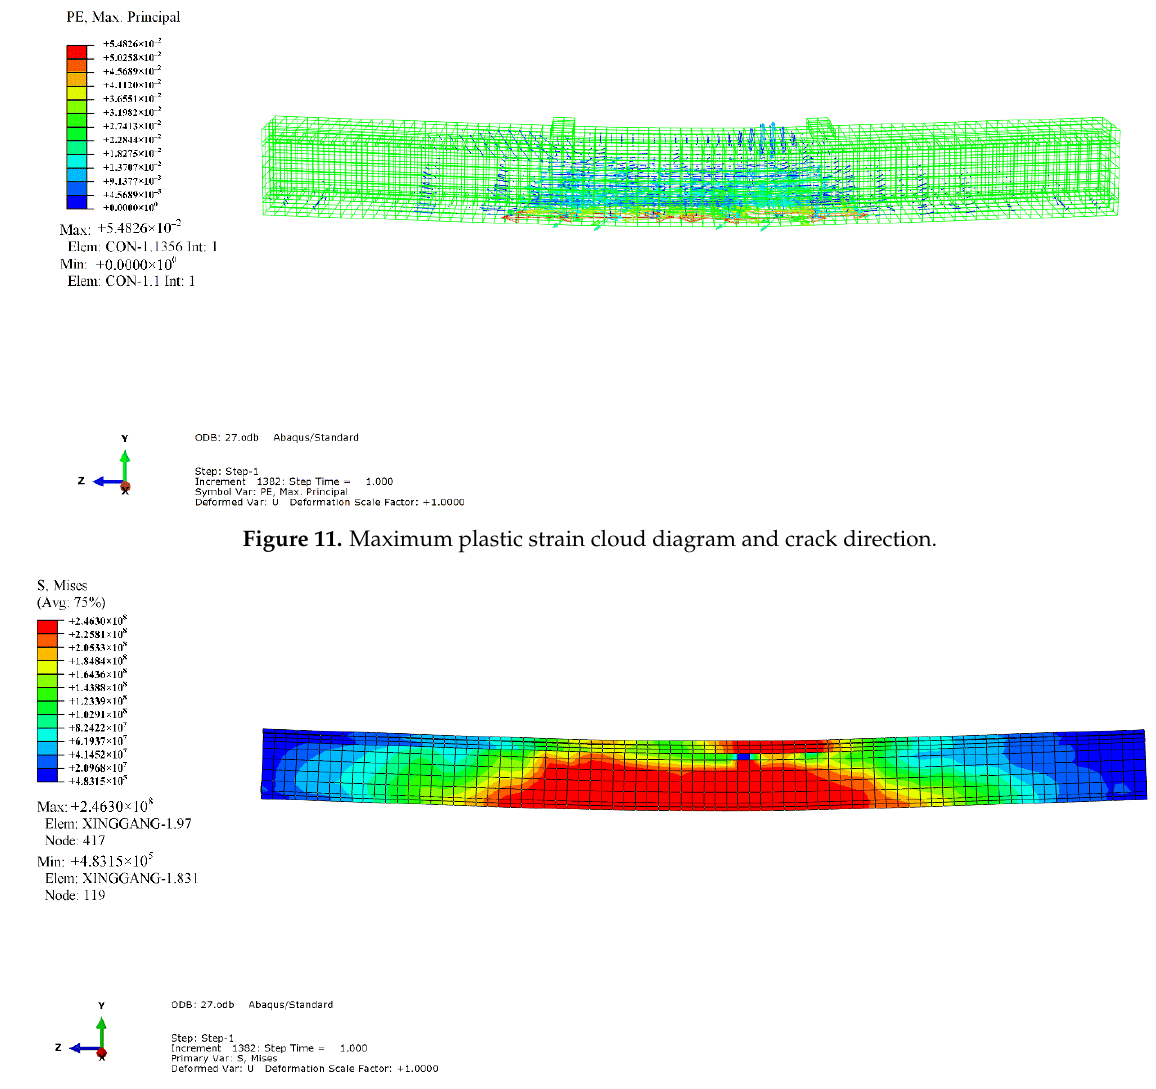
Figure 12. Von-Mises stress diagram of section steel.